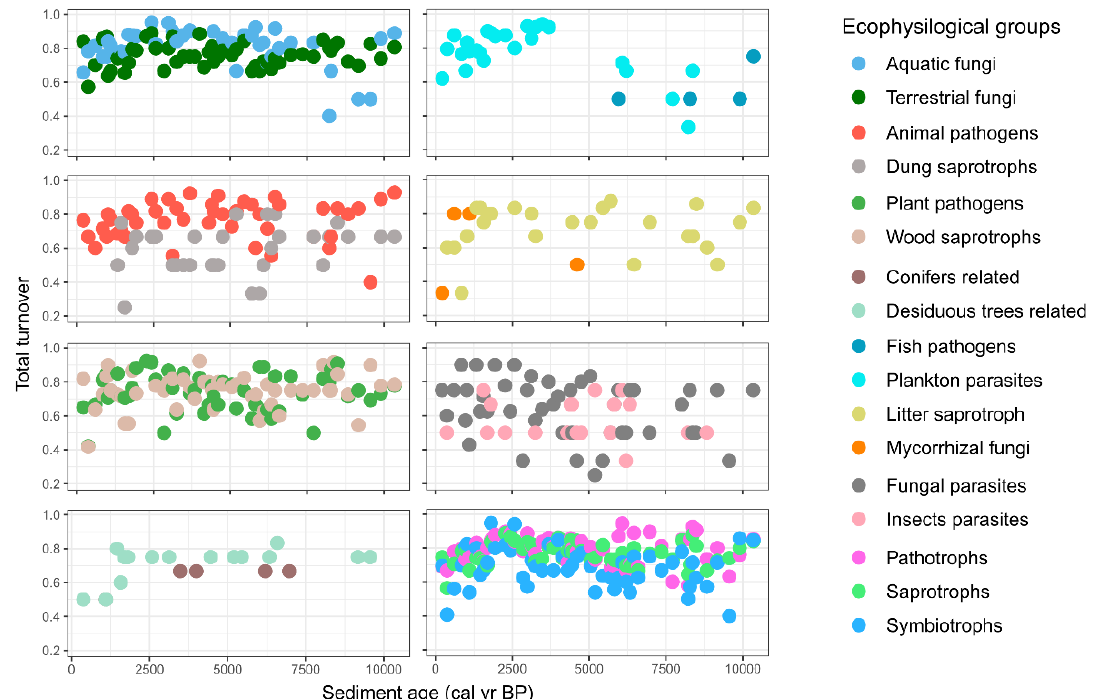
Figure 4. The total species turnover between consecutive sampling (time) points of fungal groups over the last 10.5 kyr. Total species turnover shows the proportion of different species between two time points. Table 1. Community change indexes of fungal groups over time.